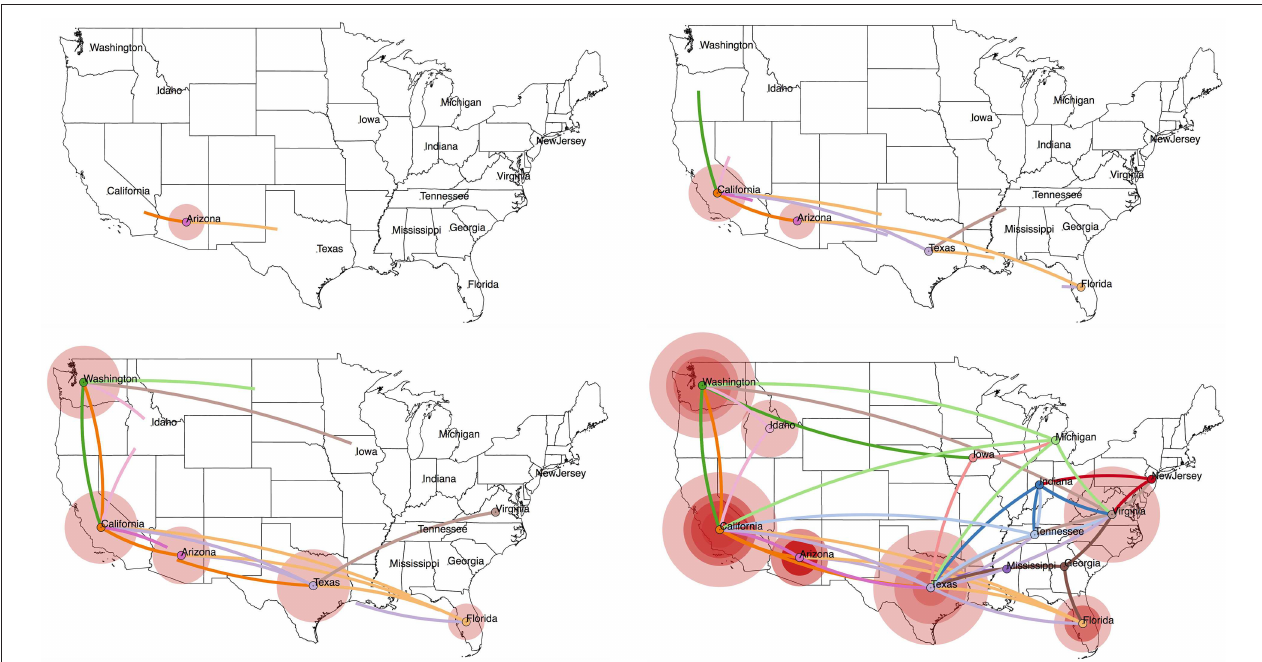
FIGURE 3 | Projecting an MCC tree onto a geographic map using SpreaD3 (40). In a discrete phylogeography setting, as is the case here, the ancestral location states are combined with coordinates corresponding to the states in the US from which the RABV samples were obtained. We use centroid coordinates for the US states to enable this visualization. SpreaD3 animates the reconstructed virus dispersal over time, and we here show four snapshots (starting from the estimated origin of the epidemic at the root node) that capture the reconstructed dispersal over time and geographic space, i.e., in 1860, 1940, 1980, and the “present” (mid 2005). The transitions between the US states are colored according to the US state of destination for that particular transition, whereas the size of the circles around a location is proportional to the number of lineages that maintain that